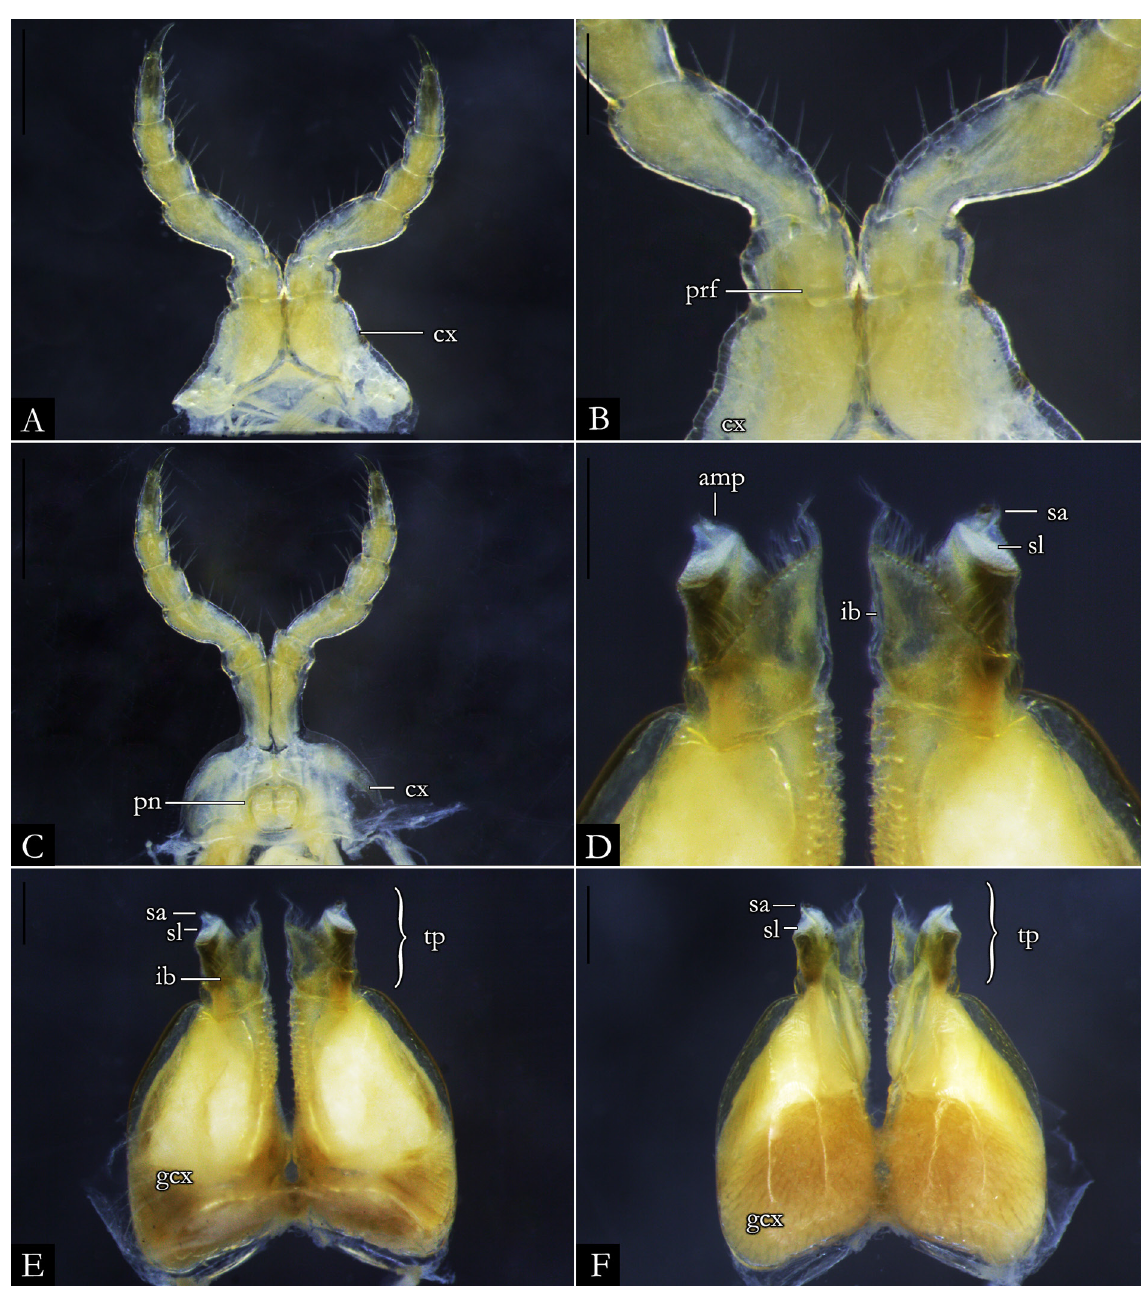
Fig. 112. Pseudonannolene pusilla Silvestri, 1895, ♂ (IBSP 13390). A . First leg-pair. B . Detail of prefemur. C . Second leg-pair. D . Detail of telopodites, in anal view. E . Gonopods, in anal view. F . Gonopods, in oral view. Abbreviations: see Material and methods. Scale bars: A, C, E–F = 0.5 mm; B, D = 0.2